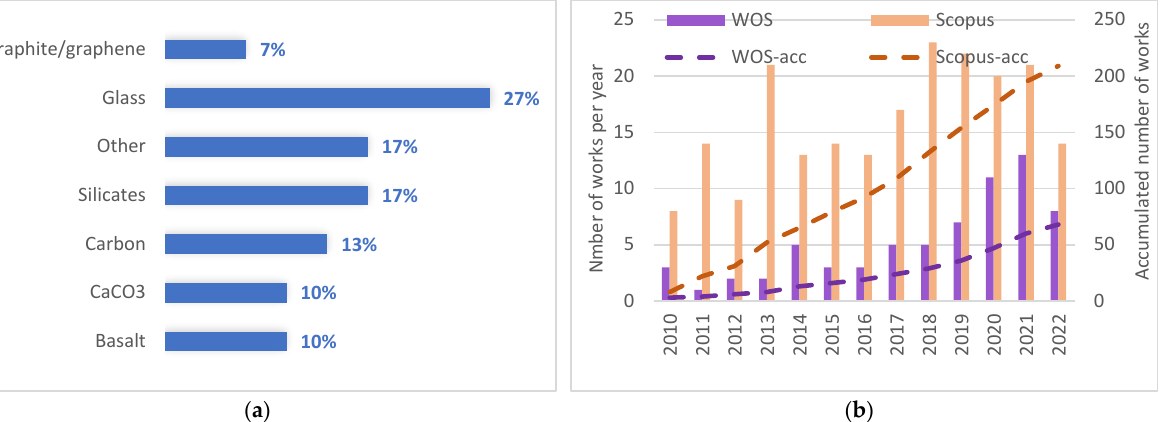
Figure 2. ( a ) Distribution of keywords related to materials from the literature review, ( b ) evolution of published papers dealing with rotomolded composites since 2010 (left axis: works published each year, in columns; right axis: accumulated works, in lines).